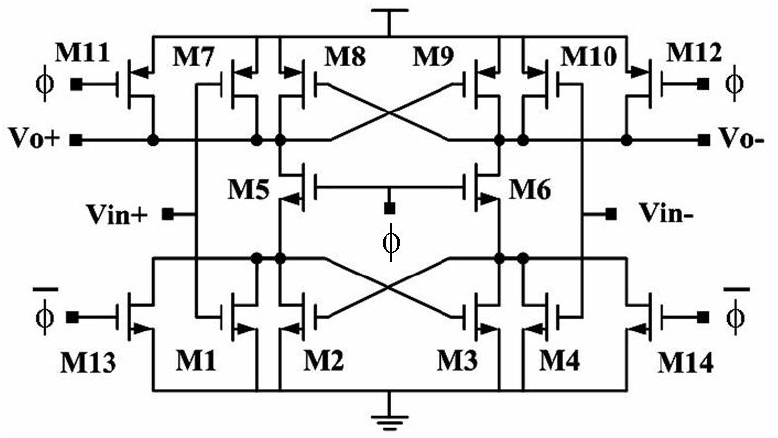
Figure 9. Proposed latch